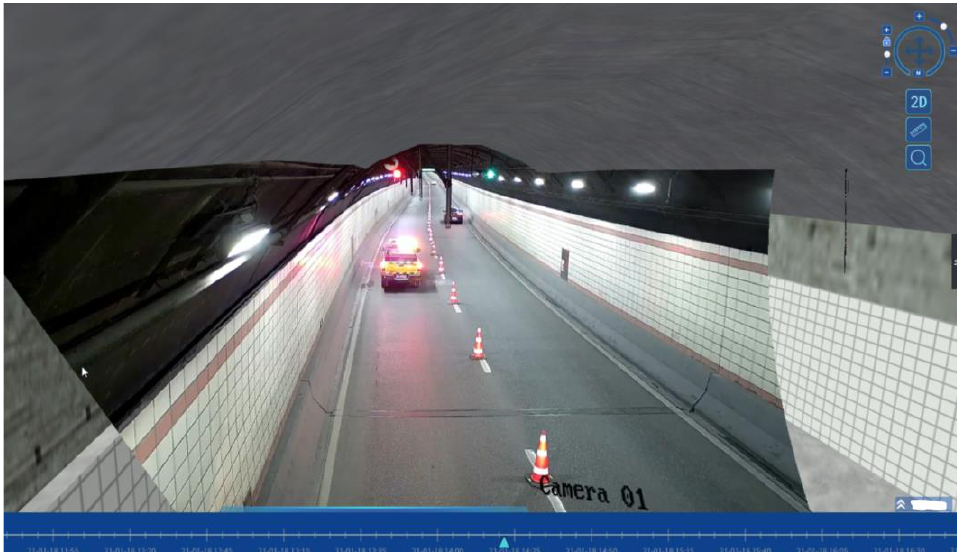
Figure 13. Historical video 3D unified backtracking forensics.